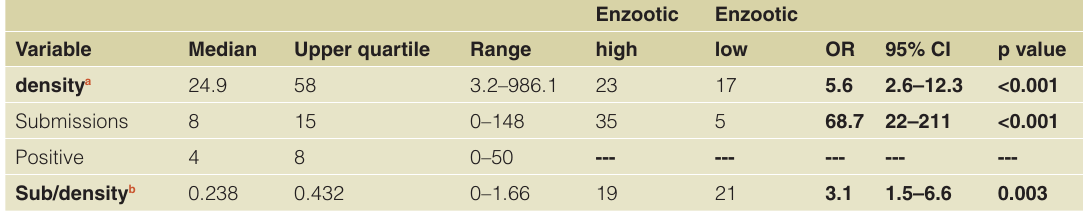
Table 1. Human demographic data, number of submissions for testing, and positive raccoon cases from 2006–2010 for 159 Georgia counties. Sub/density is the weighted variable used in the regression model. High enzootic is the number of counties in the upper quartile of positive cases ( ≥